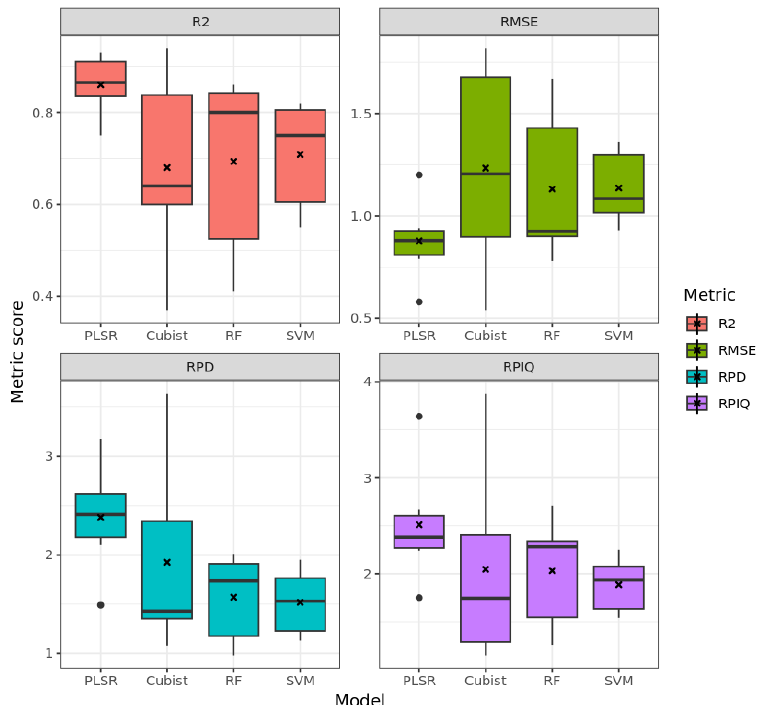
Figure 4. Box plots of the accuracy metrics for the laboratory (PSR+ 3500) estimations of OM with the use of the PLSR, Cubist, RF and SVM algorithms for all preprocessing methods.